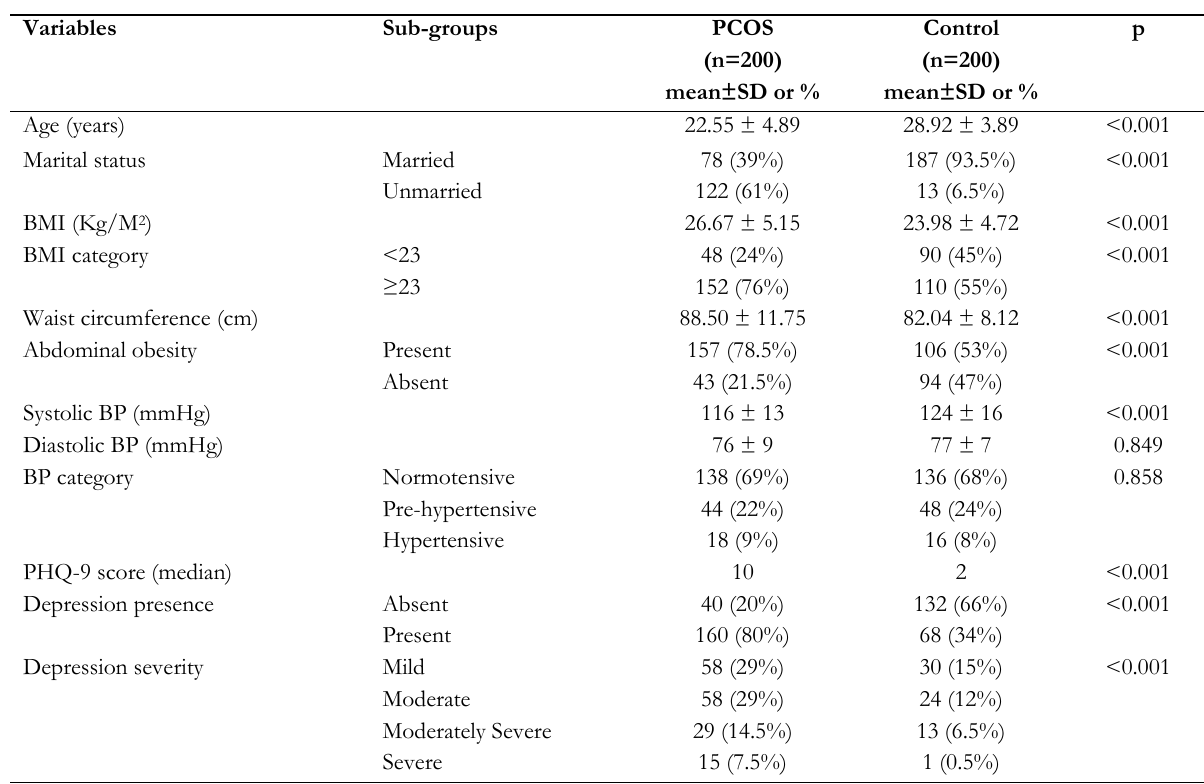
Table 1 General characteristics of the study subjects